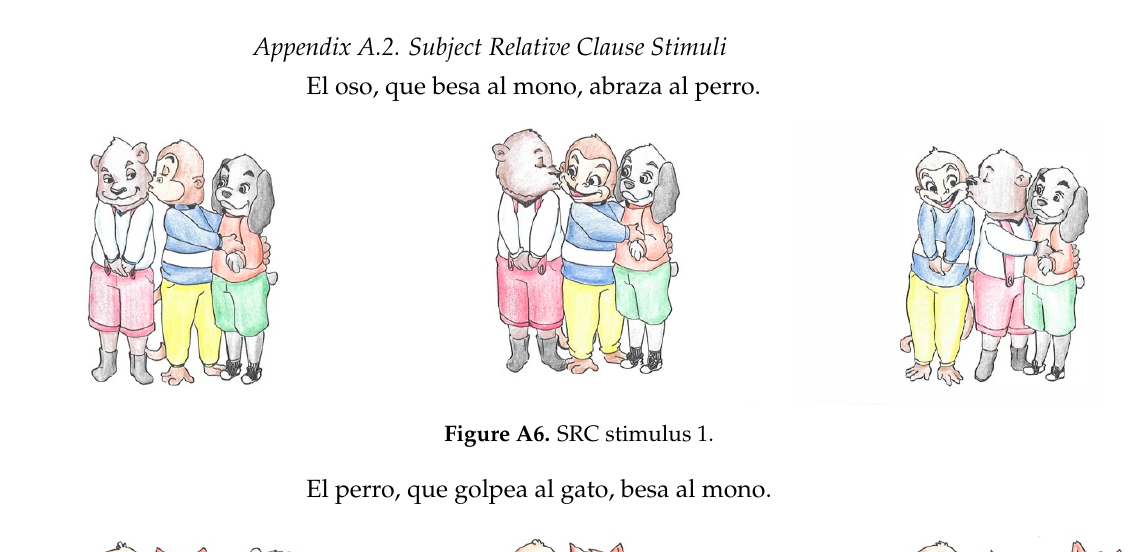
Figure A5. Practice stimulus 5.